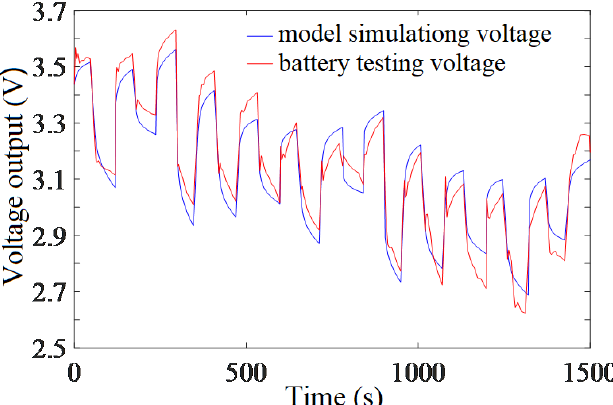
Figure 7. User-defined charge and discharge operating cycle.